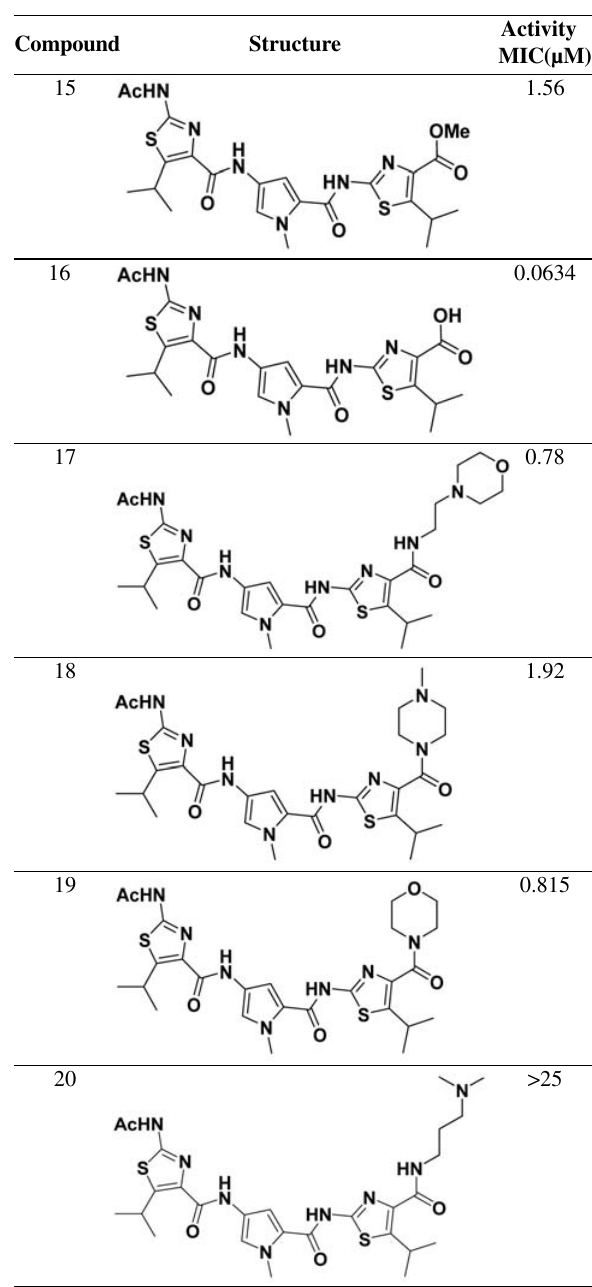
Table 3. Selected examples of anti-trypanosomal activity of heterocyclic oligoamide trimers (for more examples see reference 26)